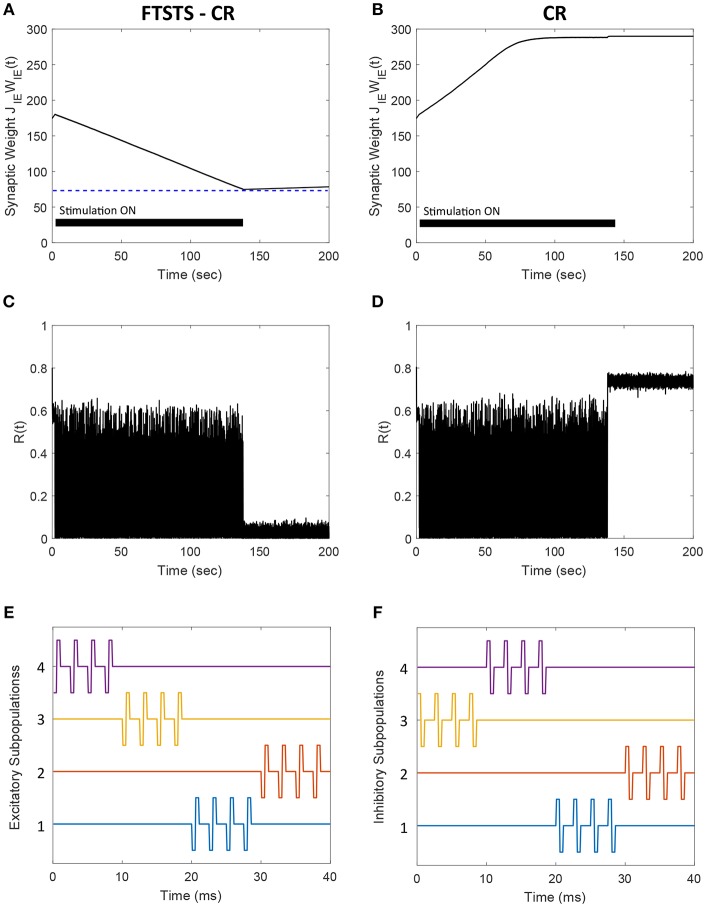
Comparison of the FTSTS-CR stimulation strategy with the coordinate-reset (CR) stimulation strategy on a network where LTP dominates LTD. (A,C) Show the changes in the average E-to-I synaptic weight of the network and the network synchrony level, respectively, for the FTSTS-CR stimulation strategy. (B,D) Show the changes in the average E-to-I synaptic weight of the network and the network synchrony level, respectively, for the CR stimulation strategy. (E,F) Show the FTSTS-CR stimulation pattern. The FTSTS-CR pulse parameters are Ustim = 200 mV, Tstim = 0.5 ms, and Tneutral = 3 ms. The STDP plasticity parameters are aLTD = −1, aLTP = 1.01,τLTD = 20 ms, and τLTP = 20 ms.